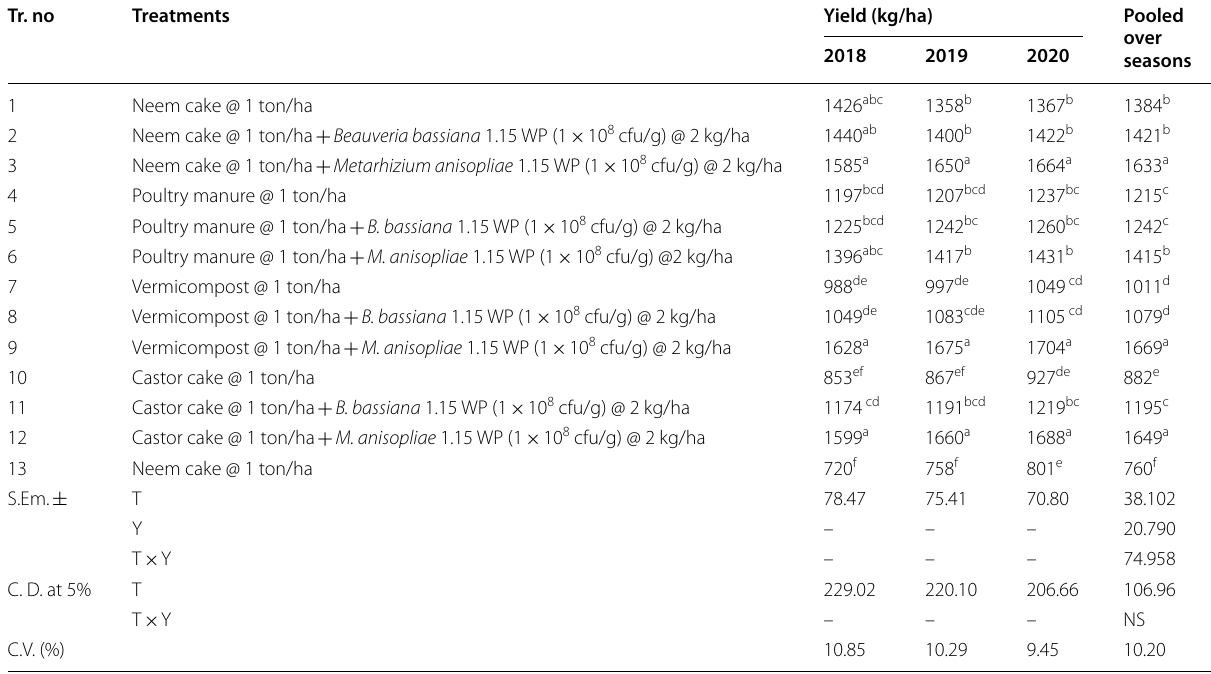
1. DAG: Days after germination; Treatment means with the letter(s) in common are not significant by DNMRT at 5% level of significance